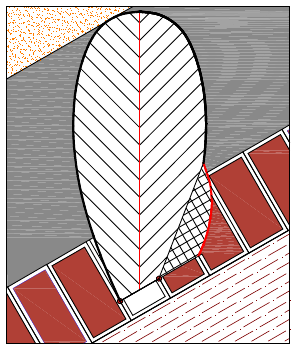
Fig. 9 Variation of drawing body shape in an inclined seam